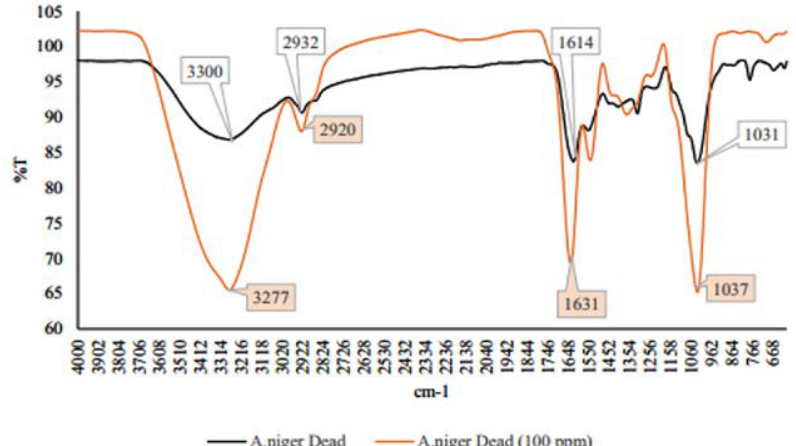
Fig. 3 . FTIR data of dead cells of A. niger before and after the absorption in 100 ppm Hg 2+